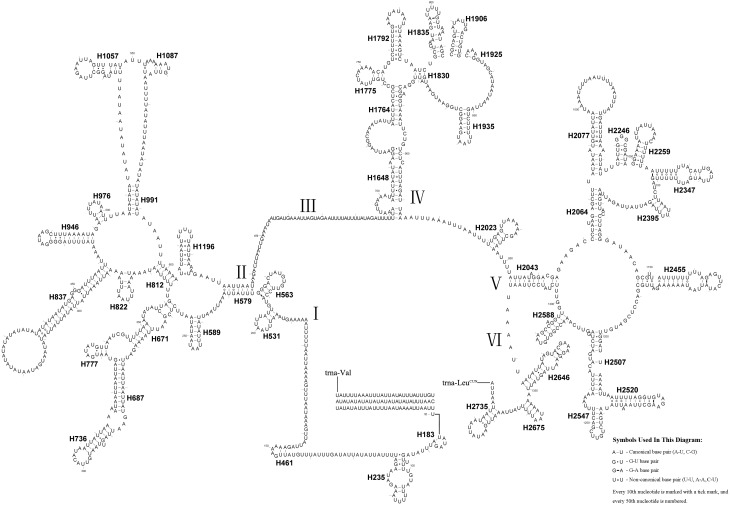
A. bella rrnL.Predicted secondary structure of rrnL in the A. bella mitochondrial genome. The numbering of helices and domain names follows Gillespie et al. (2006); roman numbers refer to domain names.